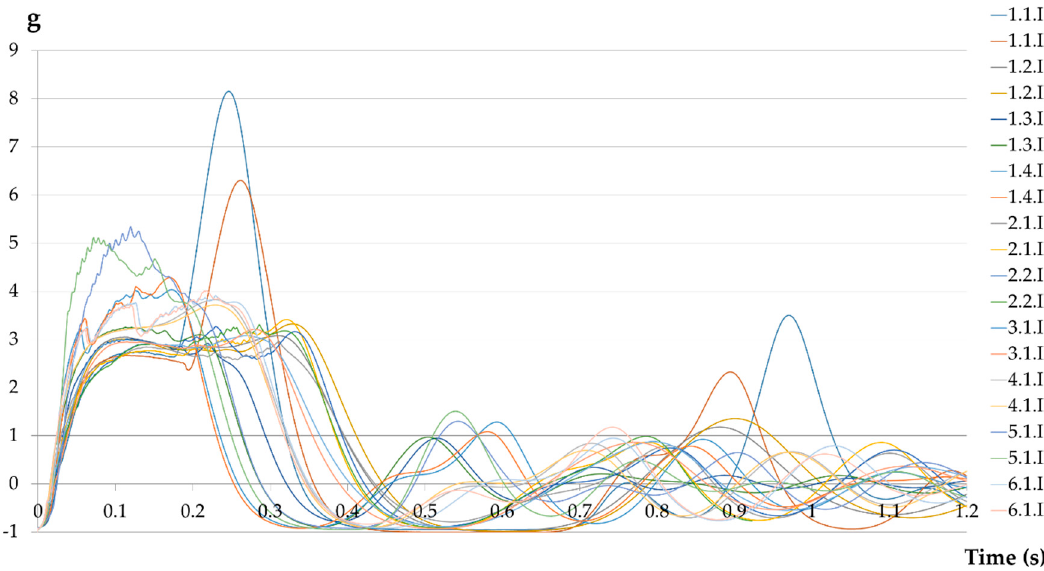
Figure 12. Mass acceleration (g).